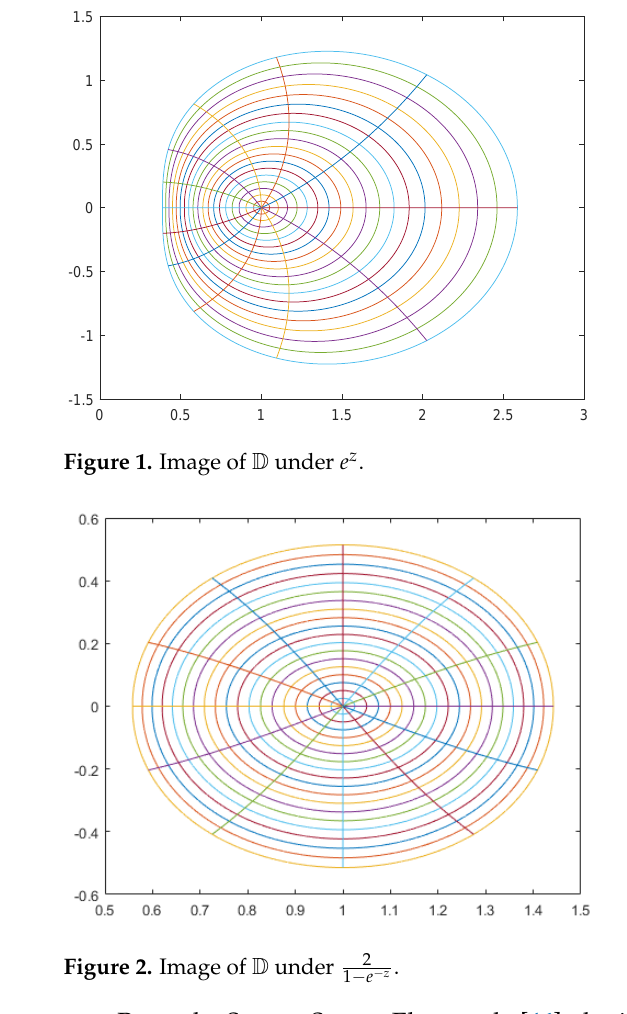
Figure 2. Image of D under 2